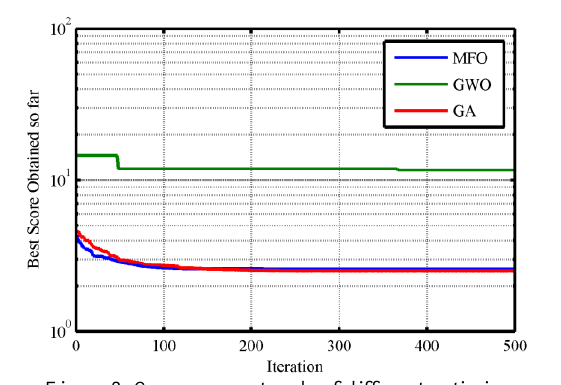
Figure 8. Convergence trends of different optimizers The clustering results of MFO-based aggregation strategy are exposed in Figure 9. Note that these results are related to a specific case that we have 10 aggregated station groups (ASG).